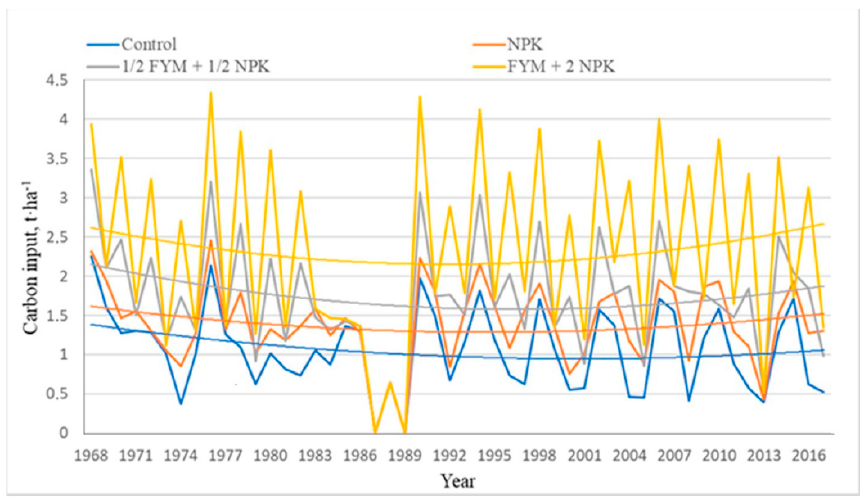
Figure 2. The annual C input in the long-term field experiment in total, with plant residues and organic fertilizers. On the axis of abscissas—the year of input, on the axis of ordinate—the total input of organic C. Smoothing was done with second-degree polynomials.